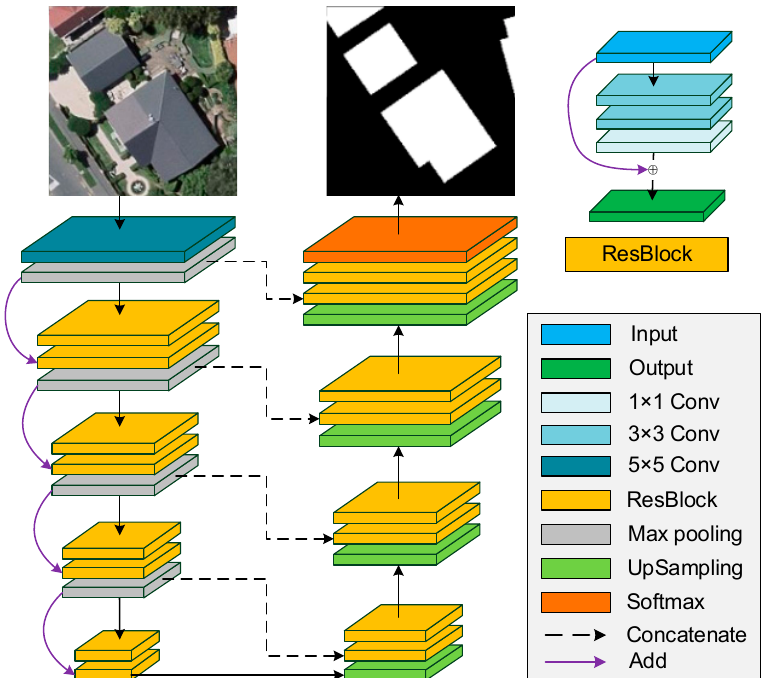
Figure 1. The architecture of the proposed DeepResUnet network. The input layer is an aerial image with three channels (red, green, blue) and the output is a binary segmentation map. The left part represents a down-sampling sub-network and the right part represents an up-sampling sub-network.